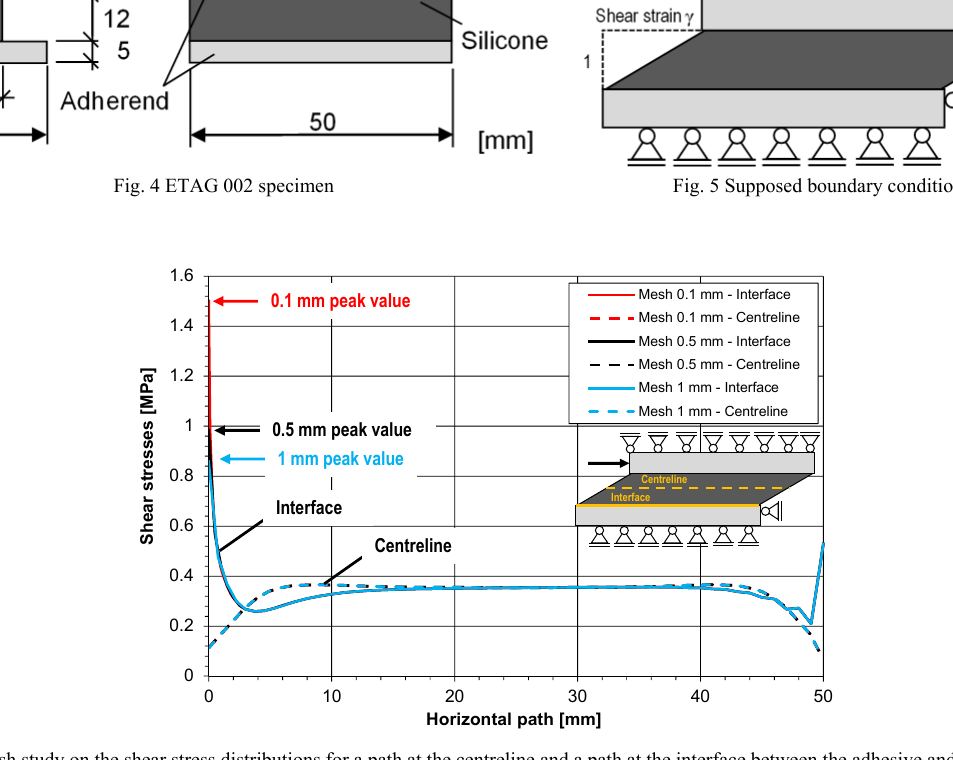
Fig. 6 Mesh study on the shear stress distributions for a path at the centreline and a path at the interface between the adhesive and the